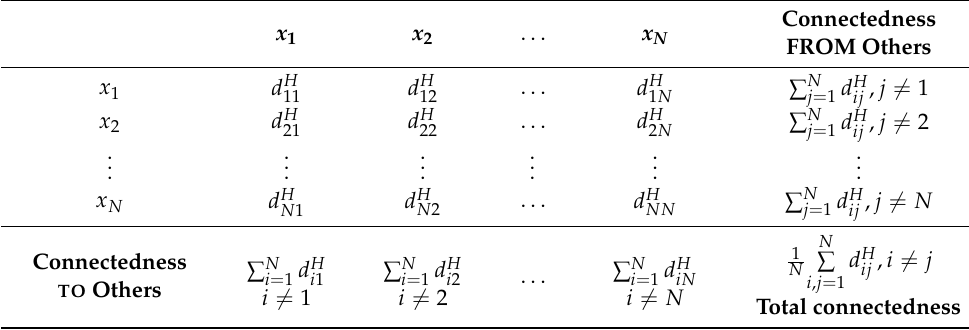
x 1 d H x 2 d H . . . x N d H